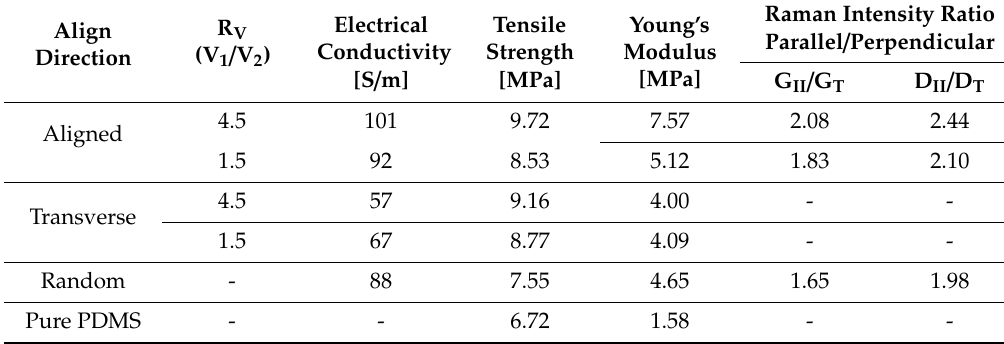
Table 1. Electrical / mechanical properties and Raman intensity ratio of the CNT / PDMS composites and pure PDMS.